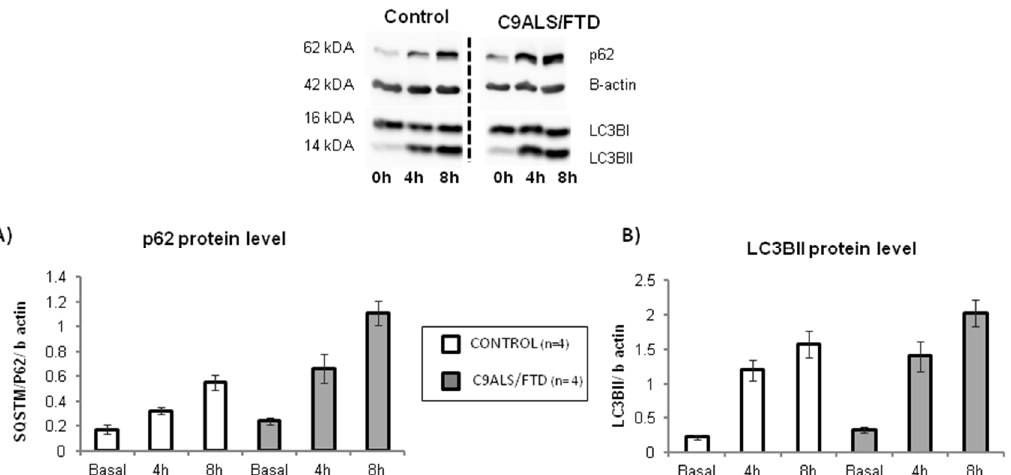
Figure 3. Autophagic flux in C9ALS/FTD patients and the control fibroblasts. ( A ) p62 and ( B ) LC3BII protein level at basal conditions (0 h) and under bafilomycin A1 treatment (4 or 8 h). The results are expressed as means ± standard error of the mean (SEM). No statistically significant results were obtained, although p62 protein levels were 2-fold increase in C9ALS/FTD patients compared to the control fibroblasts.